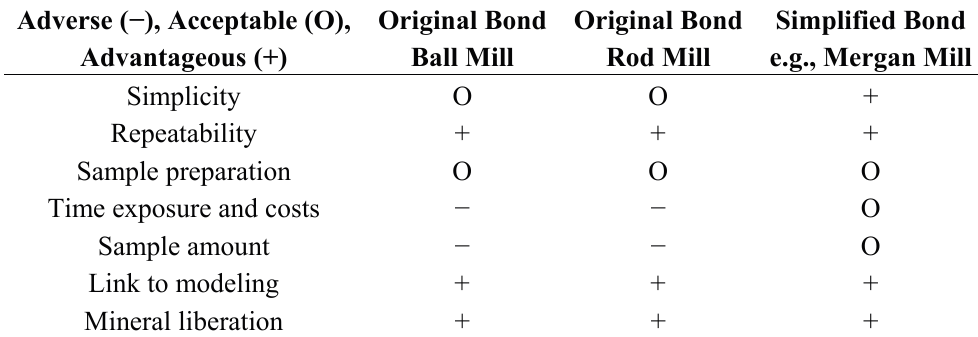
Table 3. Grindability